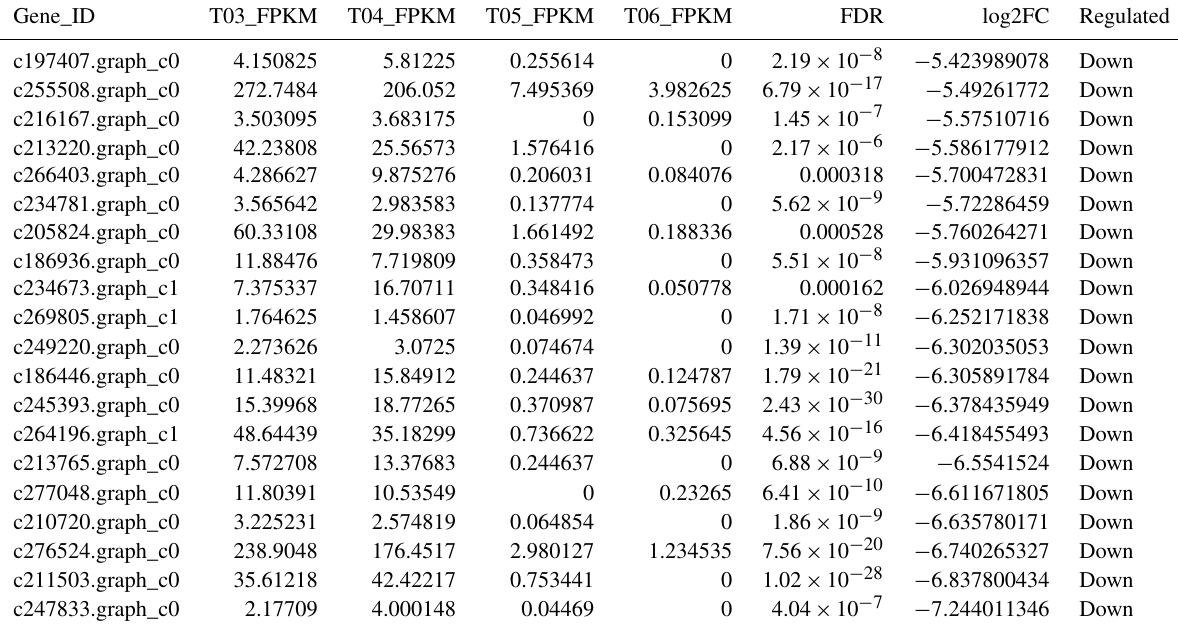
Table 4. The top 20 DEGs found to be enriched, i.e., more highly expressed, in the Pekin